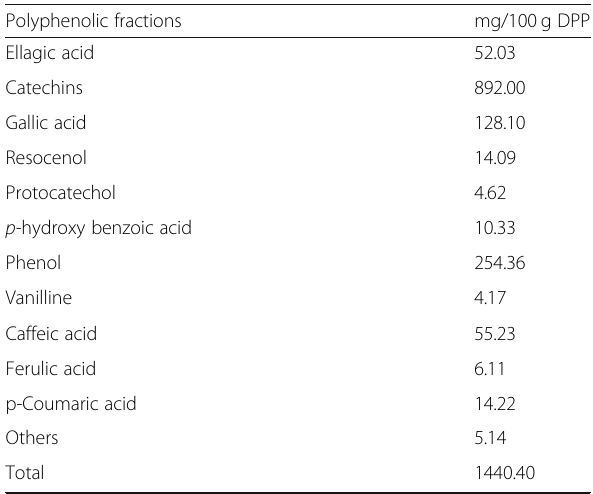
Table 6 Polyphenolic fractions content (mg/100 g) of dried pomegranate peel Polyphenolic fractions